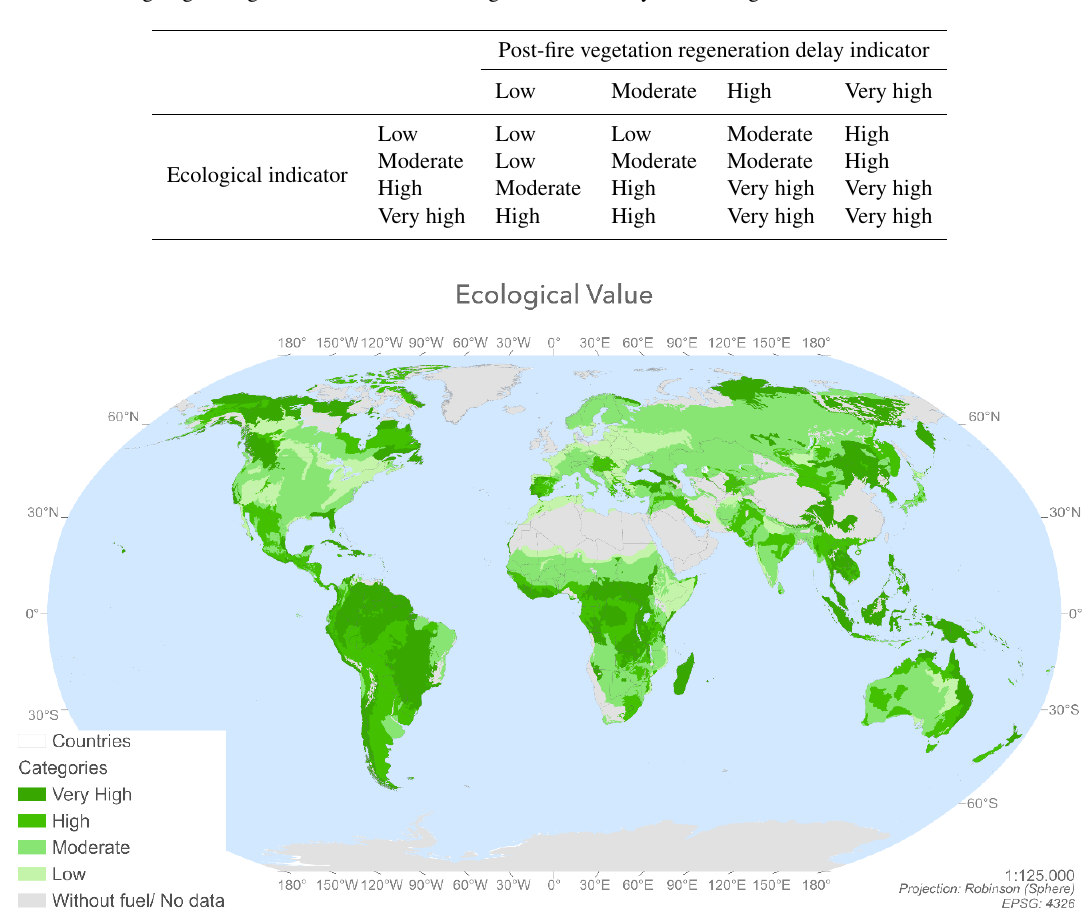
Figure 1. Spatial distribution of ecological value by ecoregion (ecological indicator) calculated by combining the biological distinctiveness (by ecoregion evaluated within the biome to which it belongs) and the conservation status (by